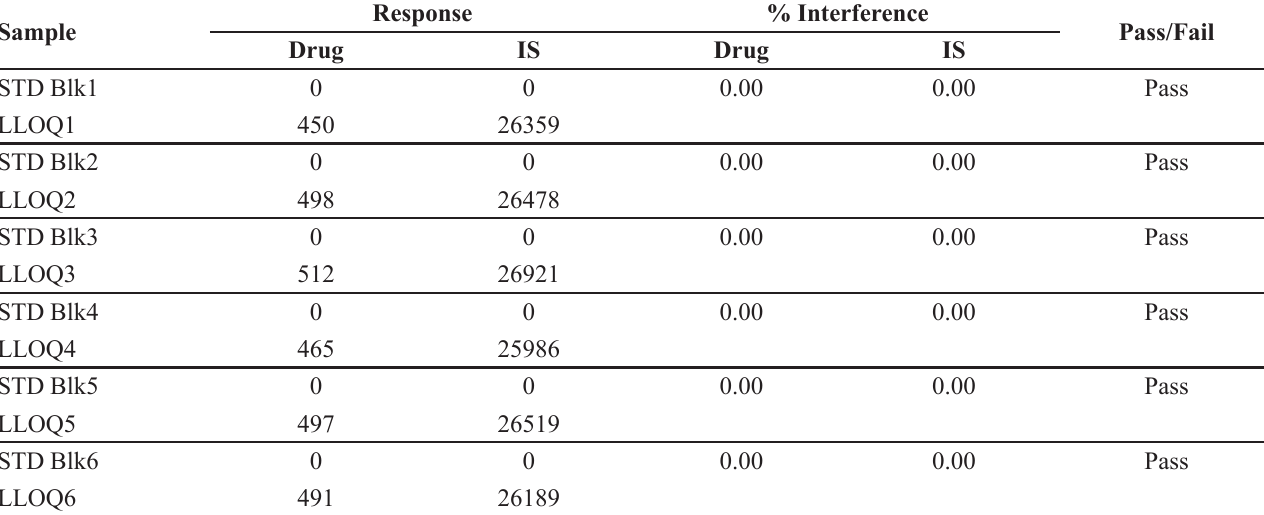
TABLE III - Specificity and screening of biological matrix